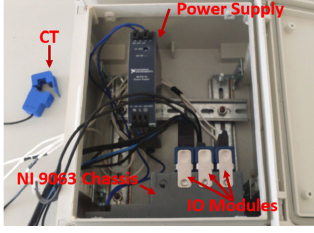
Figure 2. The IMPEC system with highlighted components in an enclosure box.